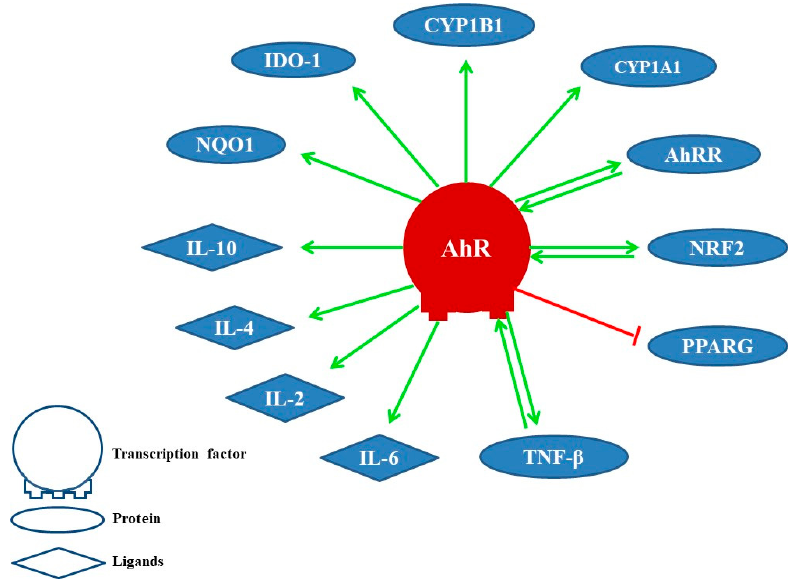
Figure 1. Proteins and ligands modulated by the AhR. Positive effect (link in green color) and negative effect (link in red color).